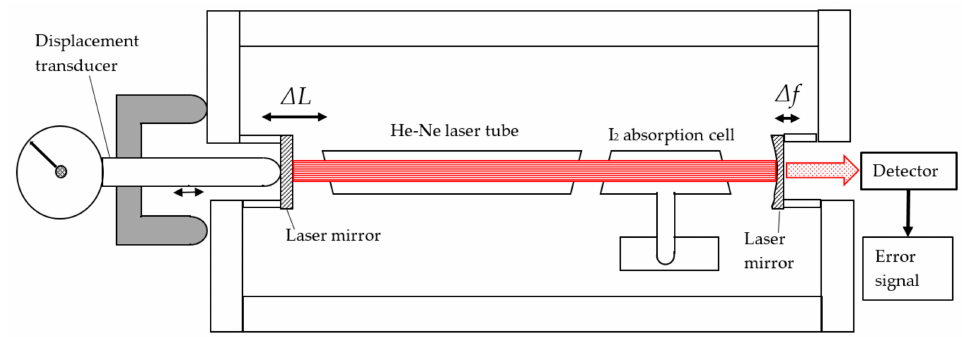
Figure 6. Sketch of an iodine-stabilized laser when used as a displacement calibration